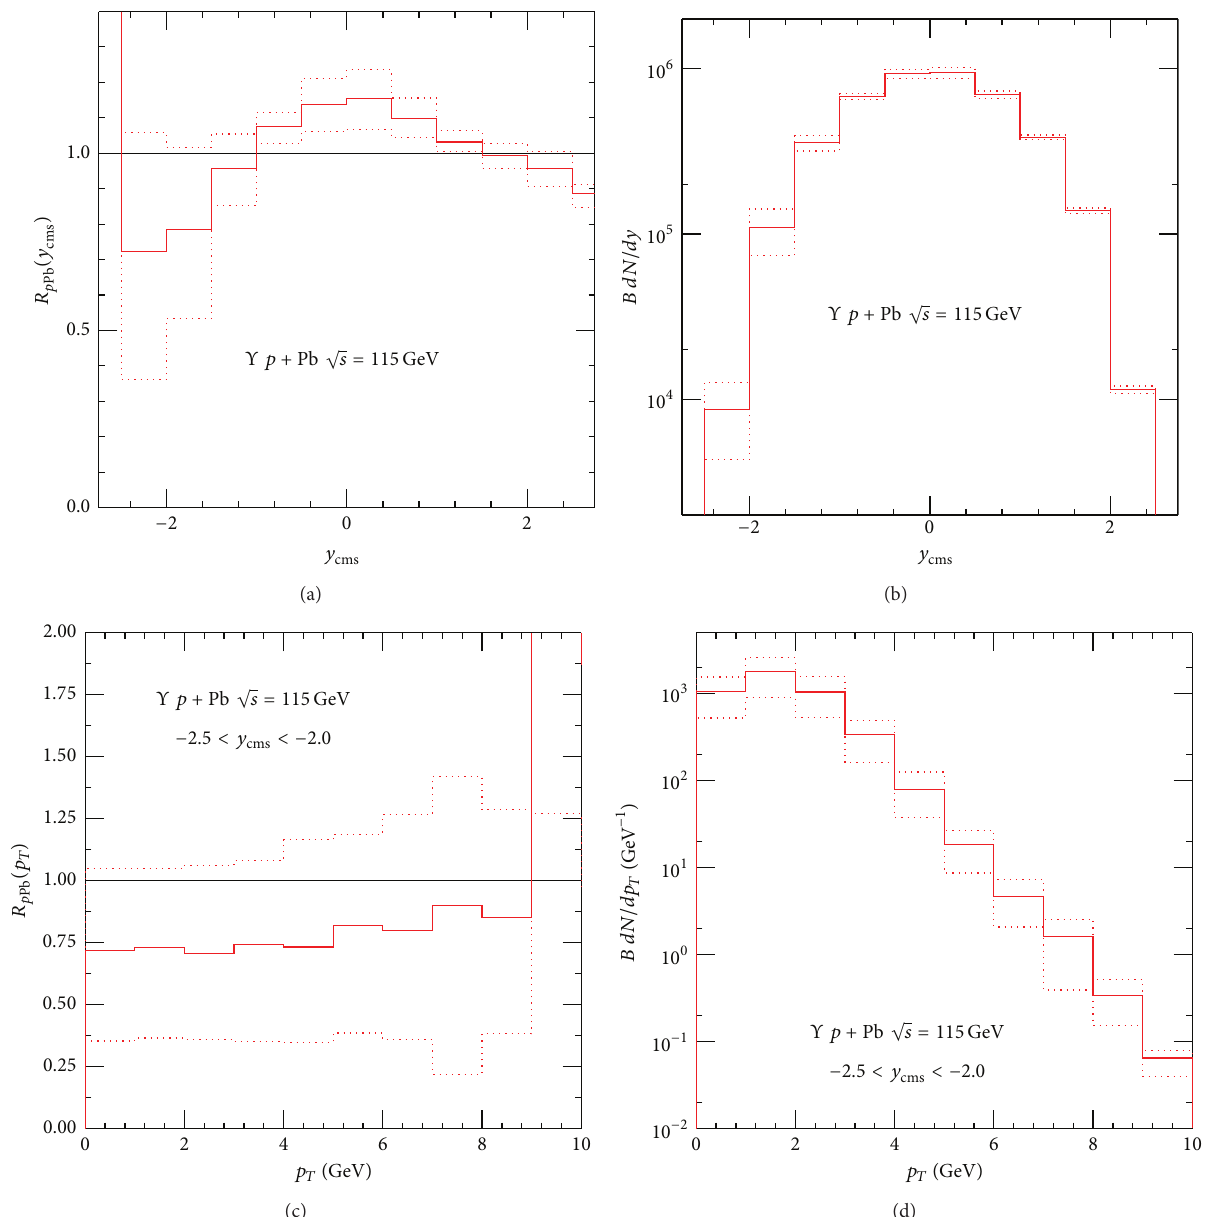
Figure 3: The predicted Υ(1𝑆) shadowing ratios (a, c) and rates (b, d) as a function of center of mass rapidity (a, b) and 𝑝 𝑇 (c, d) for 𝑝 + 𝑃𝑏 collisions at √𝑠 𝑁𝑁 = 115 GeV. The solid curve in each plot is the central EPS09 NLO result, while the dotted curves outline the shadowing uncertainty